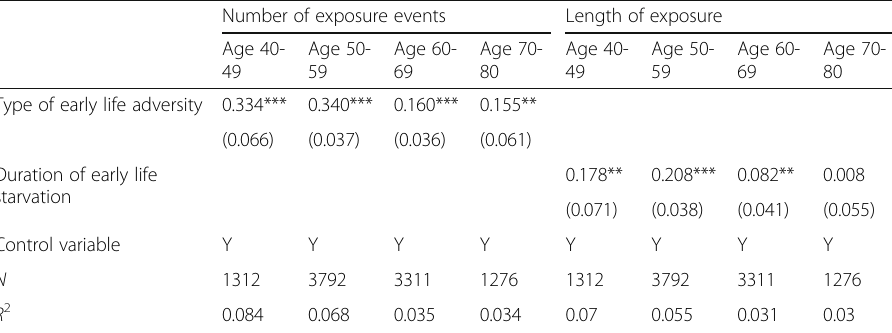
Note: Table 3 is a cross-sectional analysis using data from 2013; Table 4 is a panel data analysis matching the data from 2011 and 2013, with the sample sizes consistent between the 2years The model introduces the same control variables, including original family characteristics, initial health endowment, demographic characteristics, and provincial dummy variables * p < 0.1 ** p <